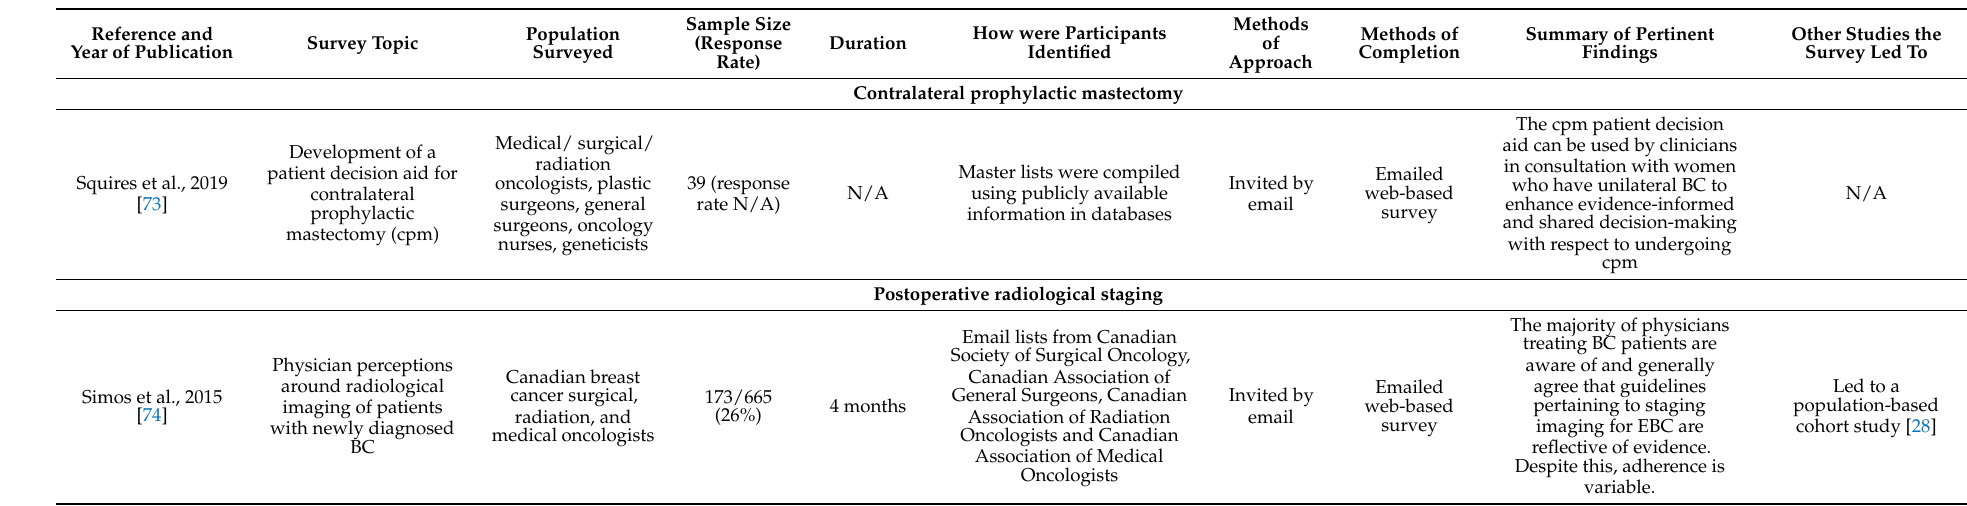
Table 2. Summary of health care provider